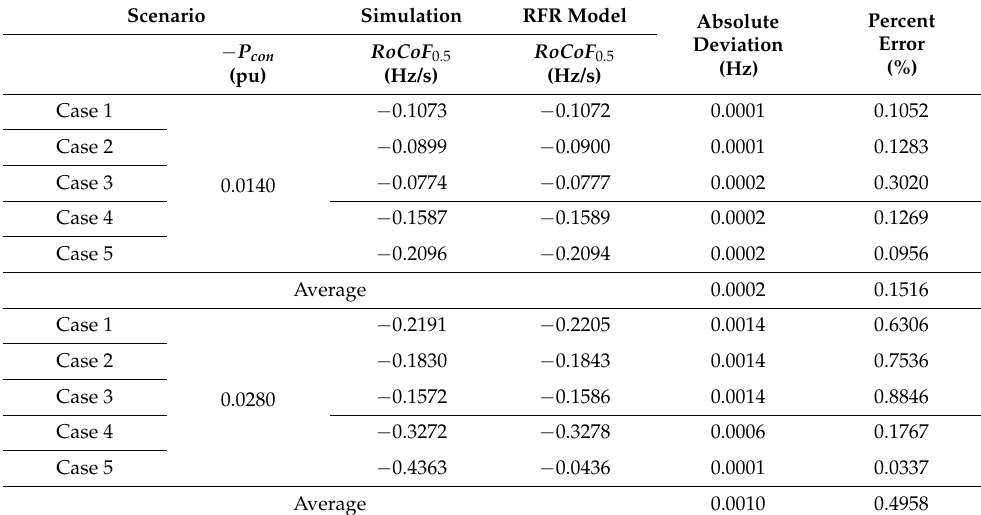
Table 3. Comparison of average RoCoF in each scenario based on 0.5 s.